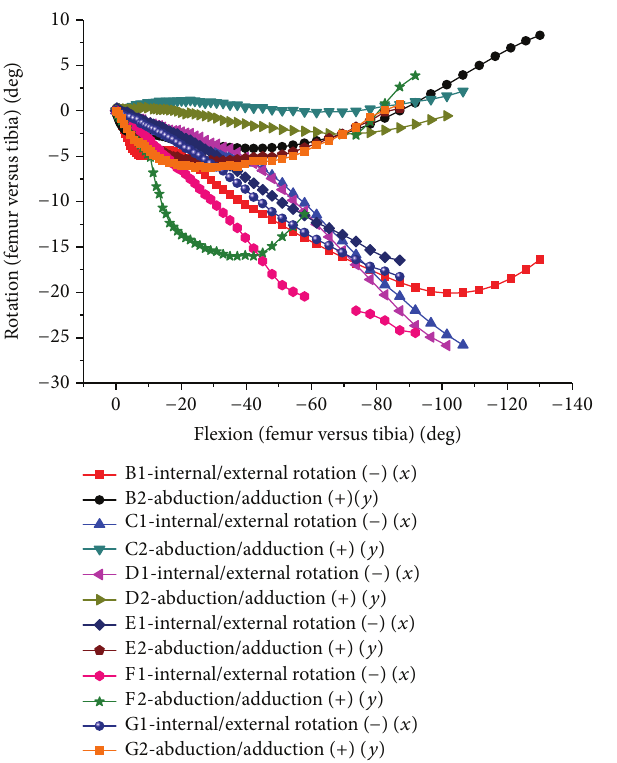
Figure 10: Internal/external and abduction/adduction of tibiofemoral joint relative movements in both test and FEA.